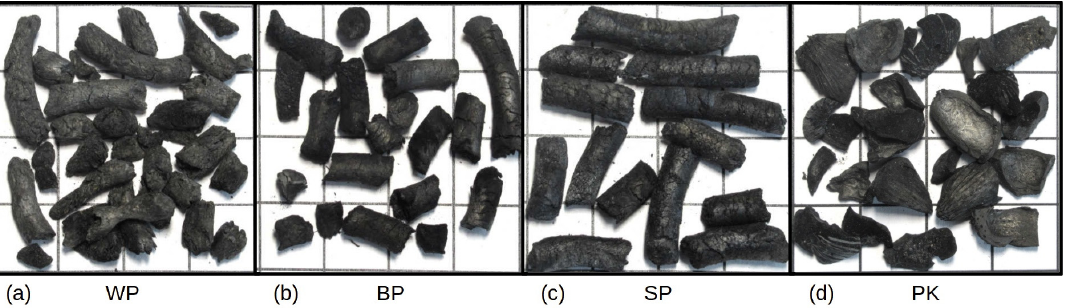
Figure 8. Produced biochar samples of the used fuels; ( a ) Wood pellets; ( b ) Bamboo pellets; ( c ) Wheat straw pellets; ( d ) Palm kernel shells; edge length of a box is 1 cm.